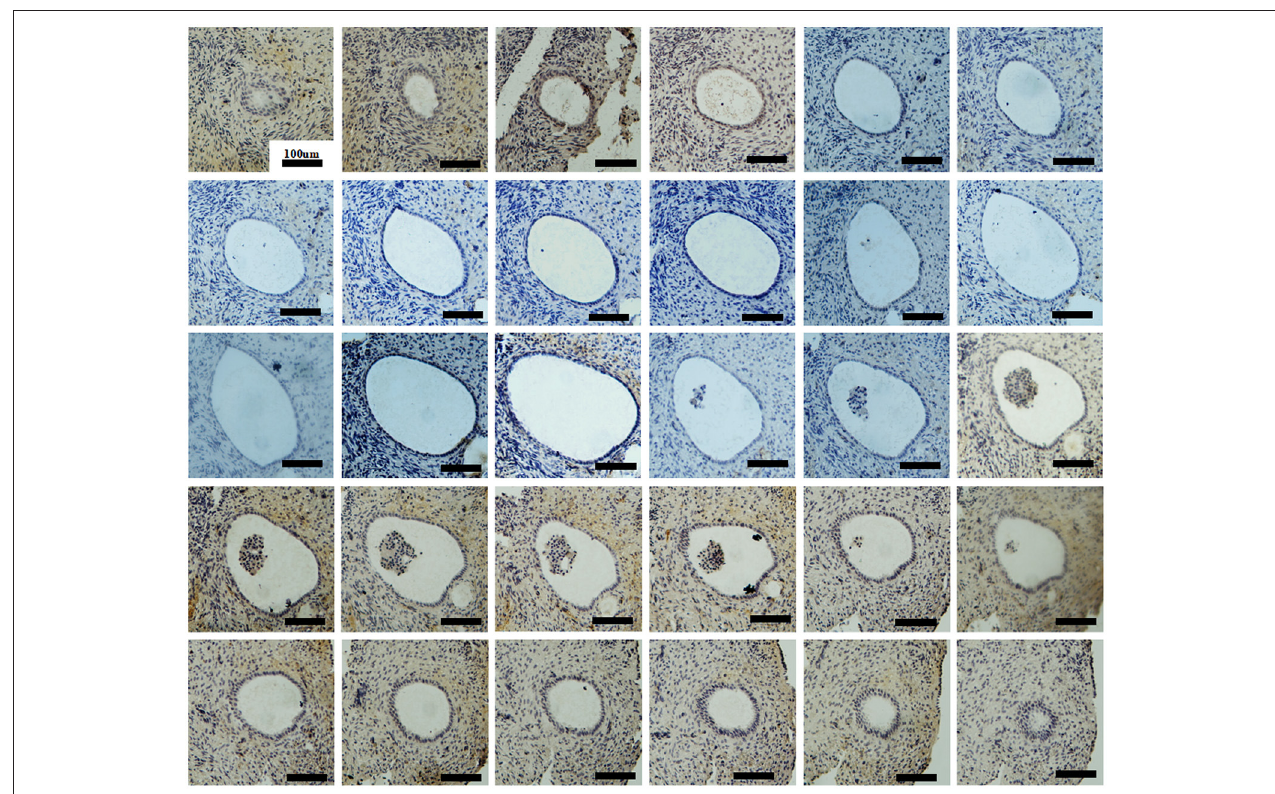
FIGURE 3 | Ovarian histology and immunohistochemistry staining of serial sections showing an intact empty follicle-like structure of the EFS patient with a heterozygous ZP3 deletion. There are a total of 30 sections with 5 µ m per section and 223 µ m in its widest